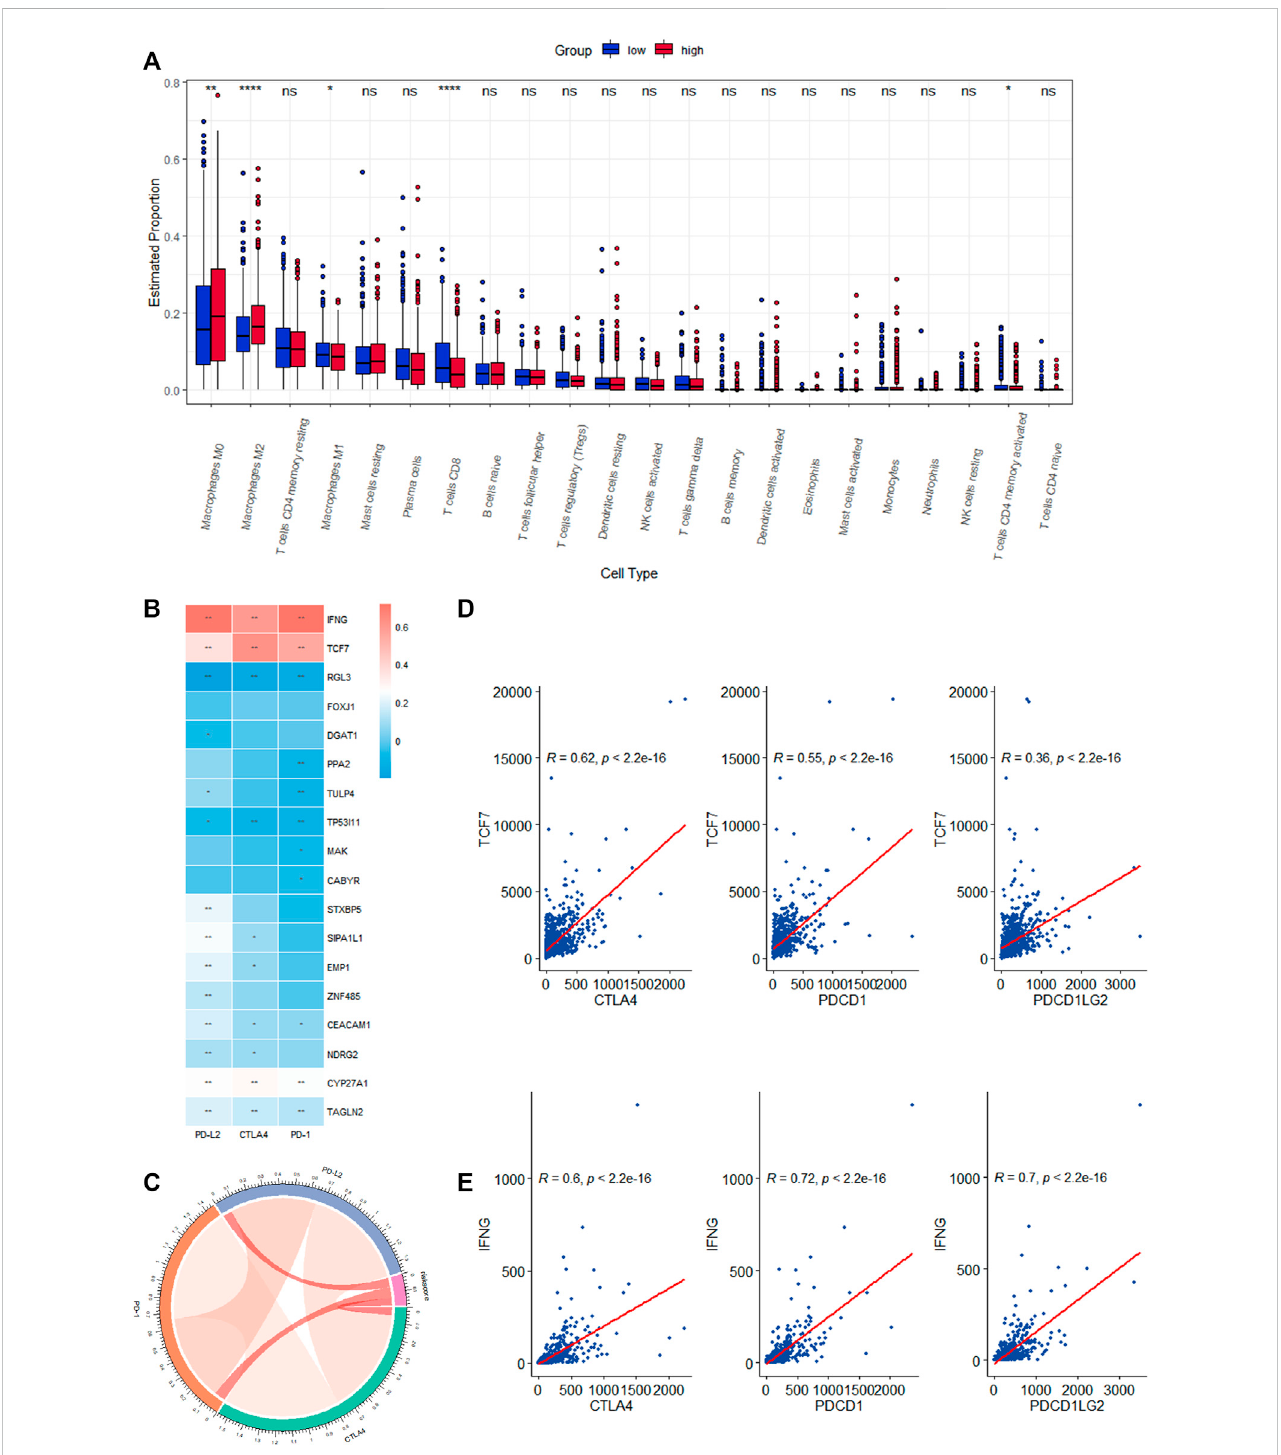
FIGURE 7 Correlation analysis of the expression of eighteen CRRGs in BC with the level of complex immune in fi ltration. (A) Differences of the abundance of 22 immune cells between high- and low-risk groups in the TCGA-BRCA dataset. (B) Correlation heat map between immune checkpoints and eighteen CRRGs. (C) Chord plot of the correlation between immune checkpoints and risk scores. (D) Correlation between TCF7 expression levels in BC and three immune checkpoints. (E) Correlation between IFNG expression levels in BC and three immune